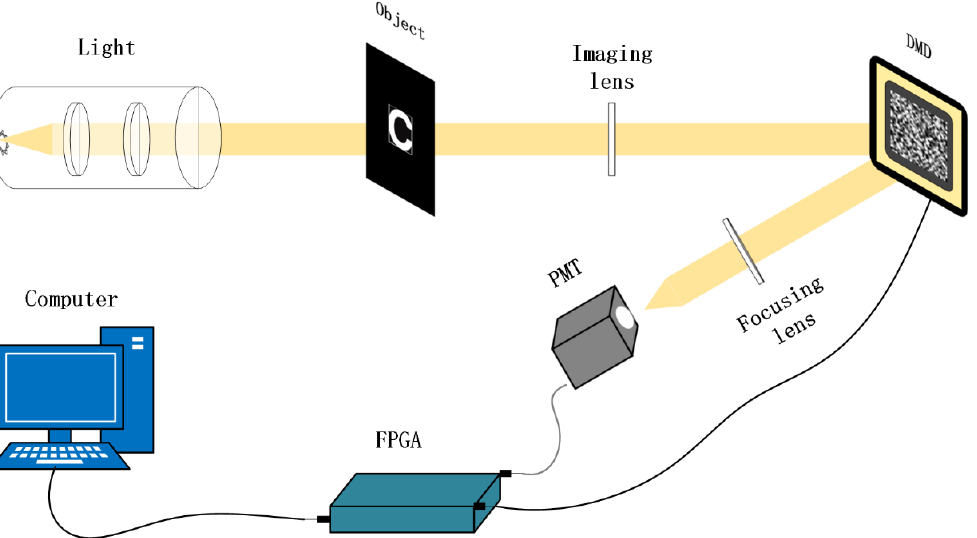
Figure 1. Single pixel imaging system, DMD: Digital Micro-Mirror Device, PMT: photomultiplier Tube, FPGA: field programmable gate array.